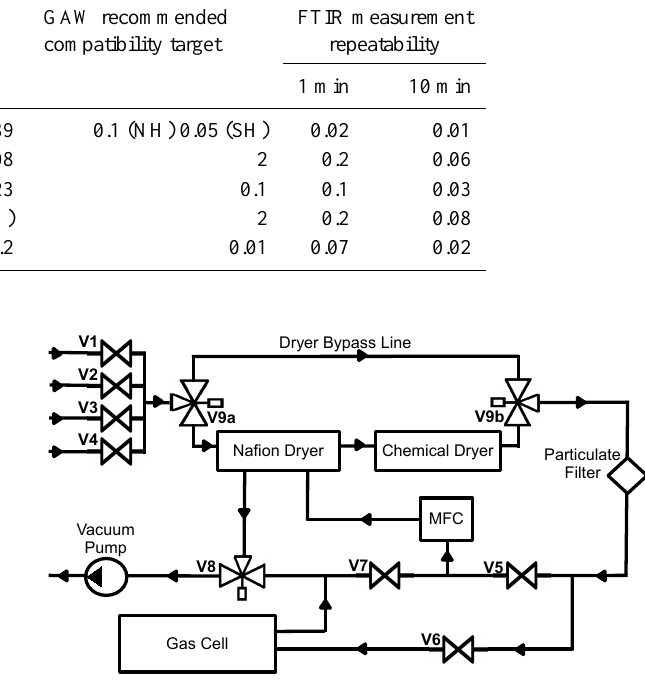
Fig. 2. Schematic view of the sampling gas manifold. For valve functions see